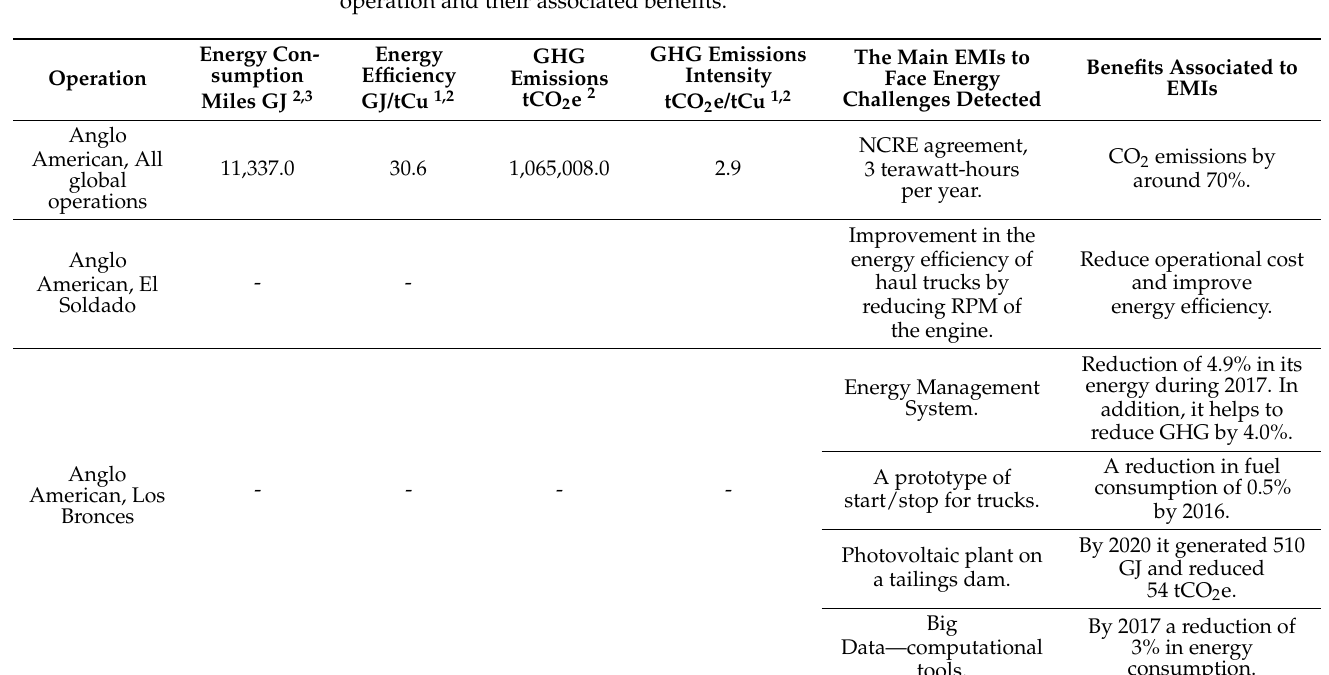
Table 5. Total energy consumption and the main EMIs to deal with energy challenges for each mining operation and their associated